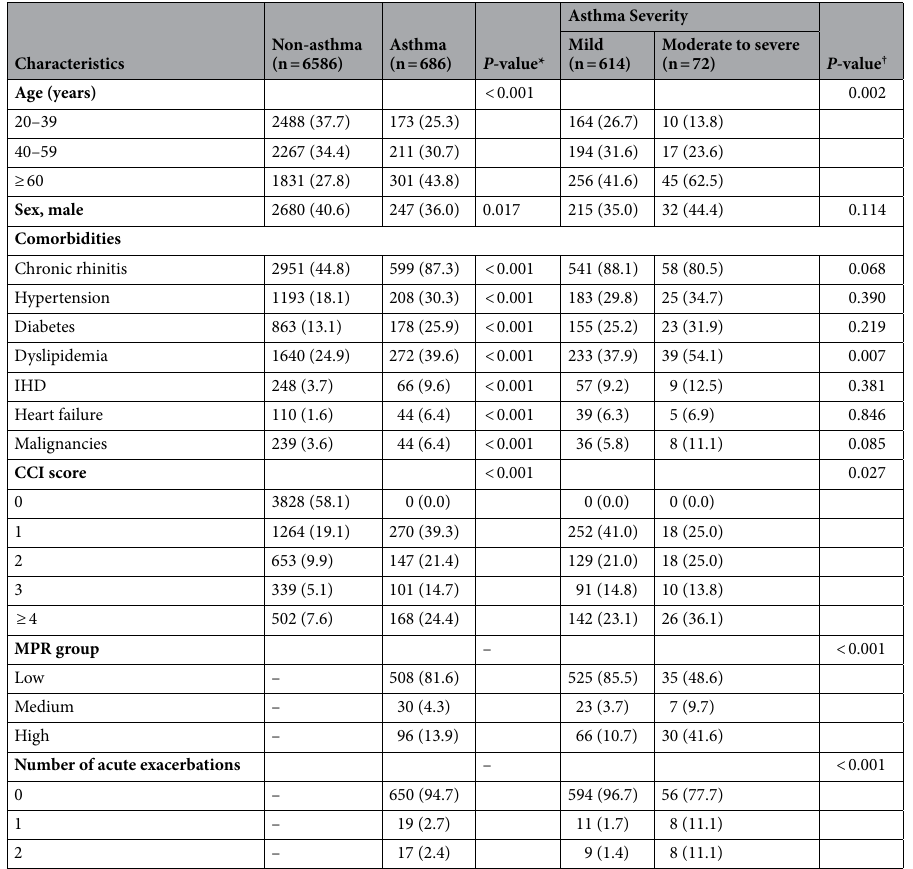
Table 1. Patient characteristics. Data are presented as numbers (%) or means ± standard deviations. IHD, ischemic heart disease; CCI, Charlson comorbidity index; MPR, medication possession ratio. * P -value for comparison between asthma and non-asthma groups. † P -value for comparison between mild and moderate- severe